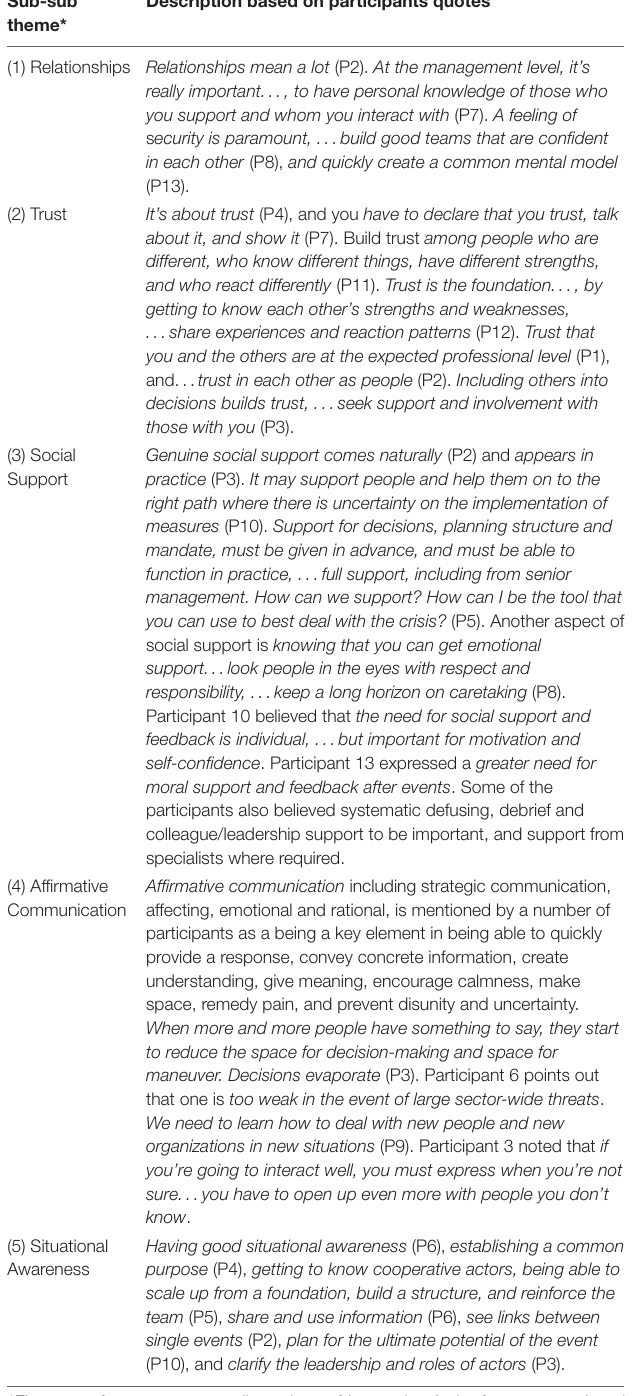
TABLE 6 | The five sub-themes (elements of competence) of interaction. Sub-sub Description based on participants theme*